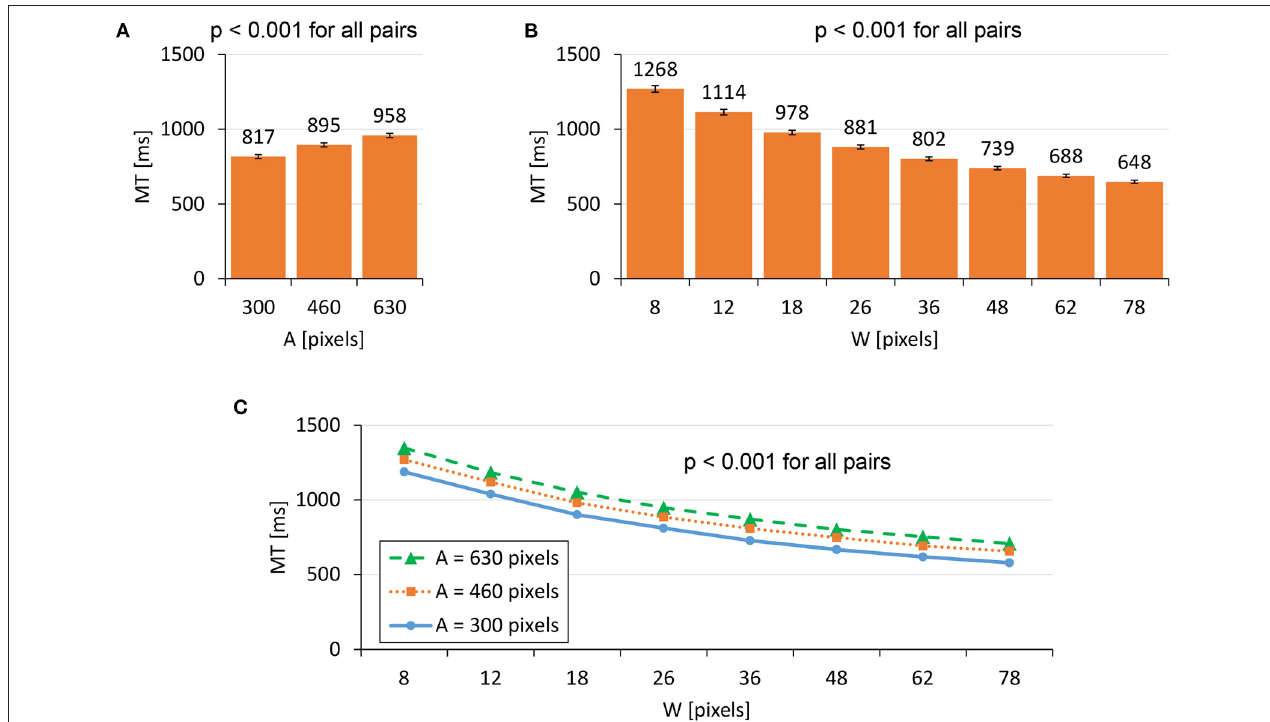
W on MT . Error bars indicate 95% confidence ×